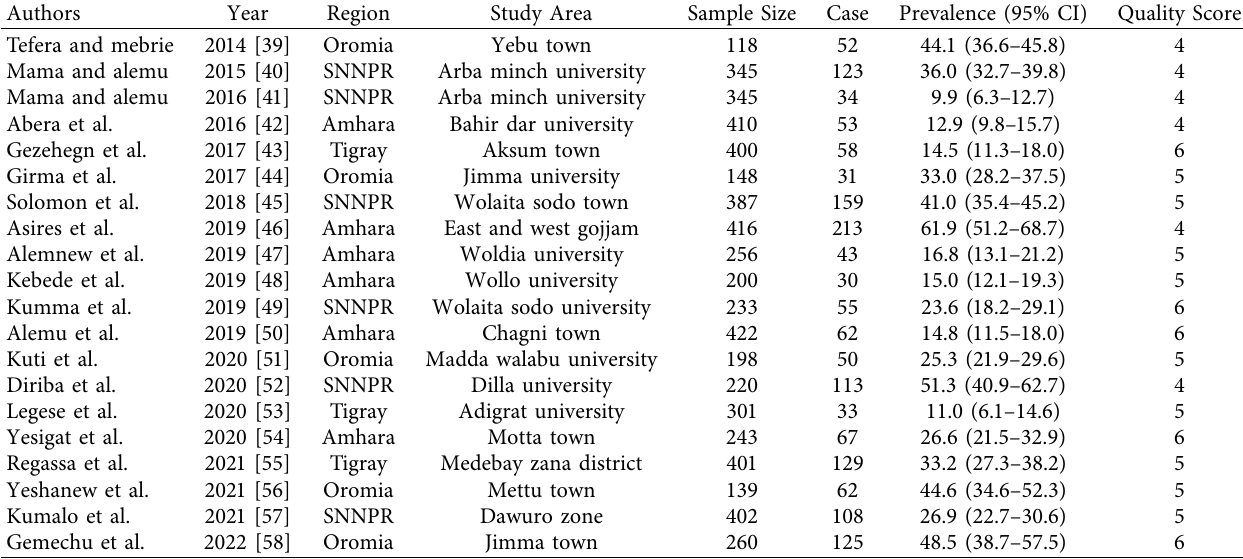
Table 2: List and characteristics of 20 eligible studies conducted from 2014 to 2022 among food